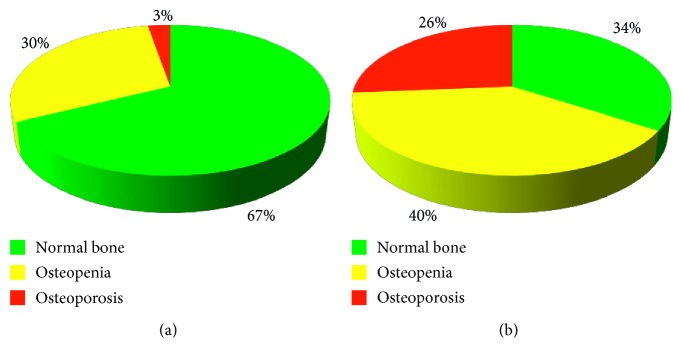
Proportion of participants from the control group (a) and men with PD (b) with different bone mineral densities (normal, osteopenia, and osteoporosis).